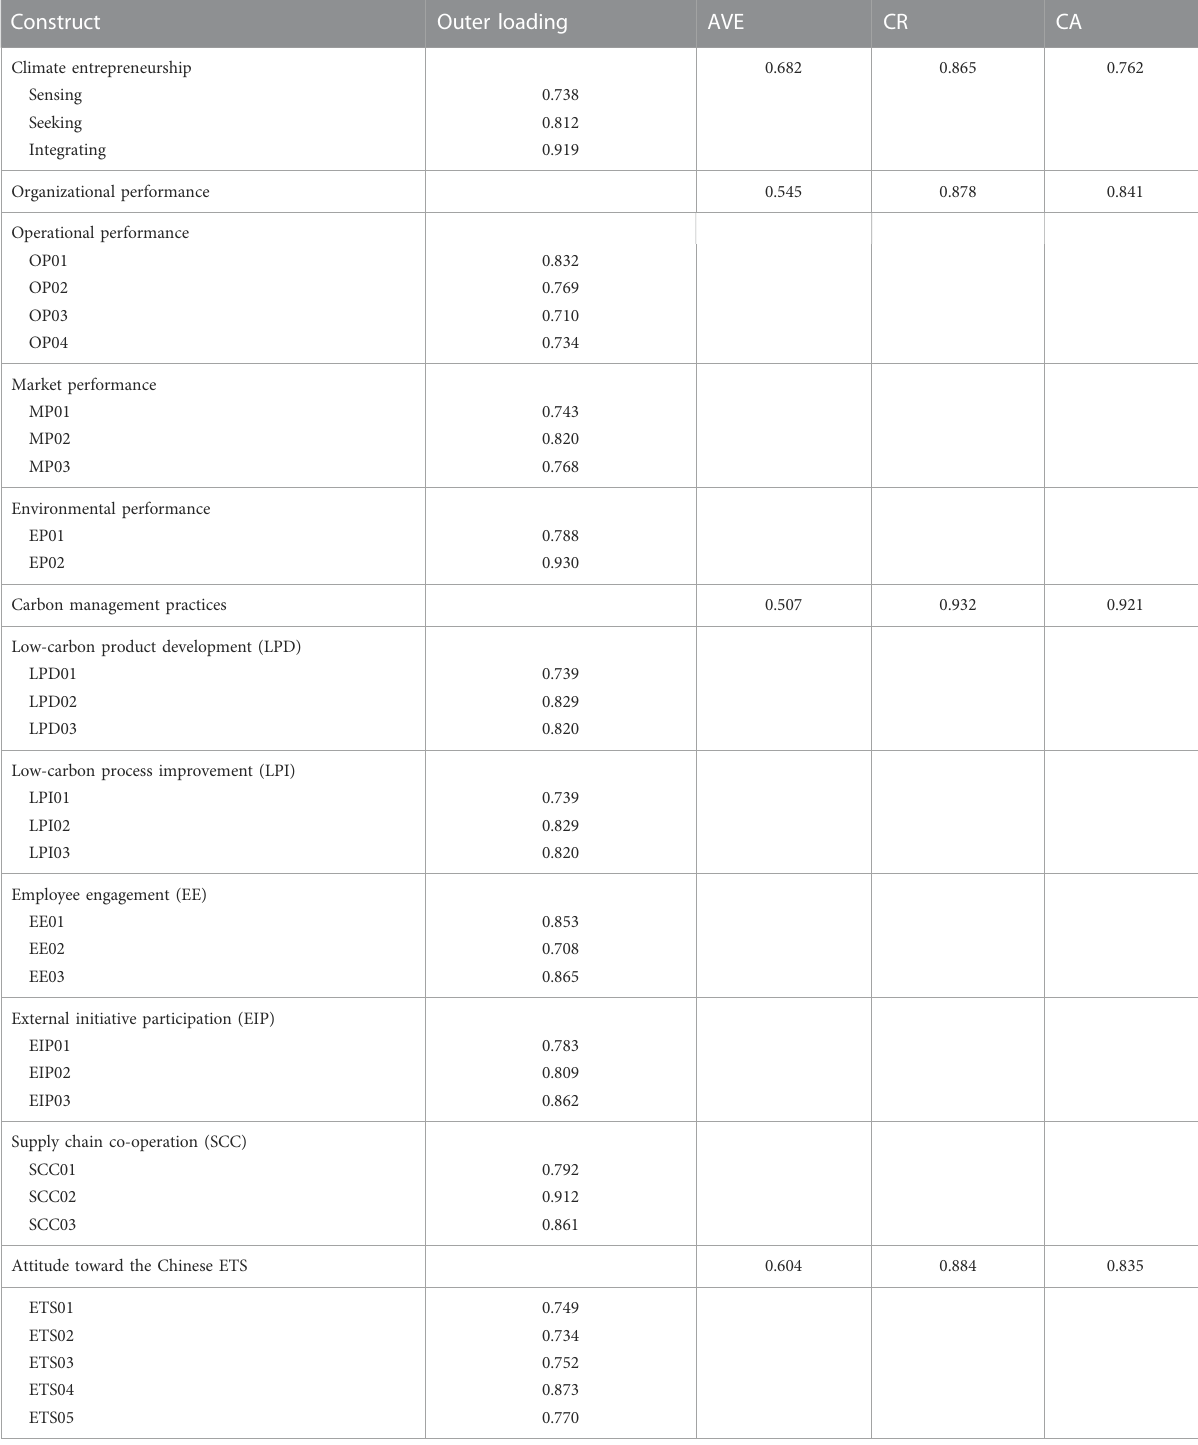
TABLE 1 Reliabilities and